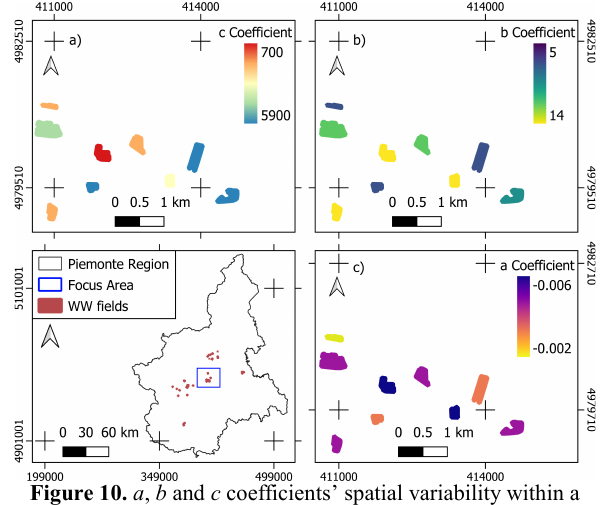
Figure 10. a , b and c coefficients’ spatial variability within a focus area in Piemonte Region. (Reference System: WGS84/UTM 32 N).